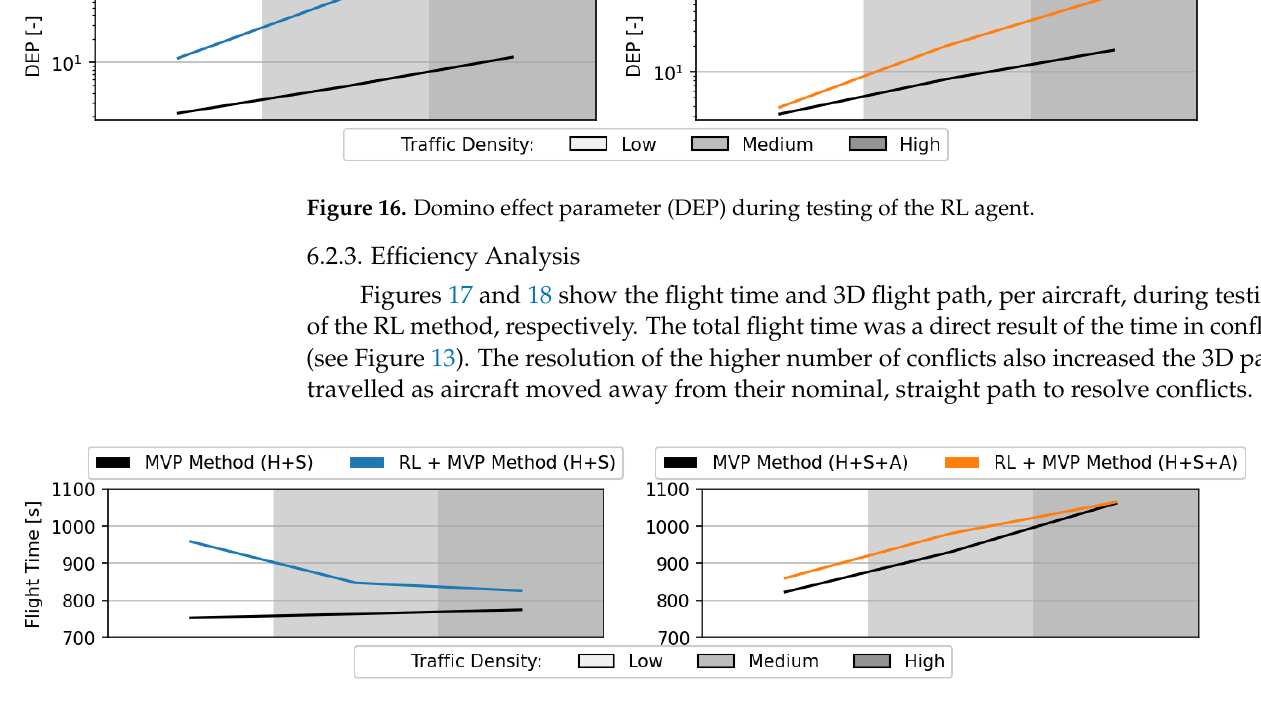
Figure 17. Flight time during testing of the RL agent.